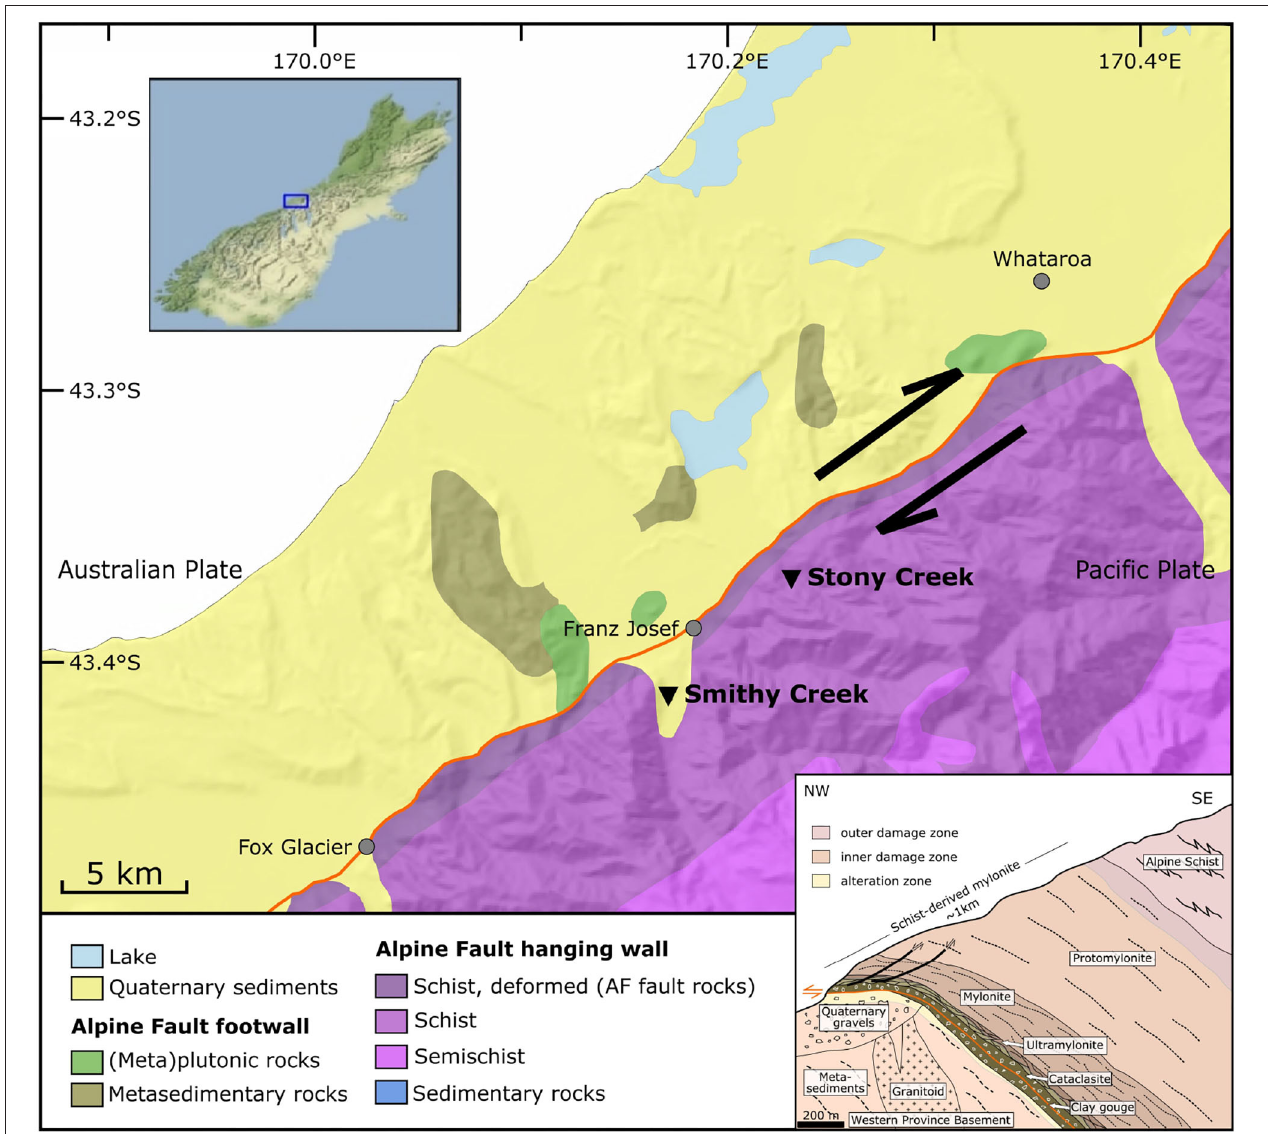
FIGURE 1 | Simplified geological map of the study area and cross-section showing typical shallow-depth sequence of the Alpine Fault rocks (Norris and Cooper, 2007; Schuck et al., 2020). Alpine Fault trace shown in orange; Stony Creek and Smithy Creek are indicated by black triangles. Map is based on the geological map of New Zealand’s South Island (Edbrooke et al., 2015) and the digital elevation model of Columbus et al.